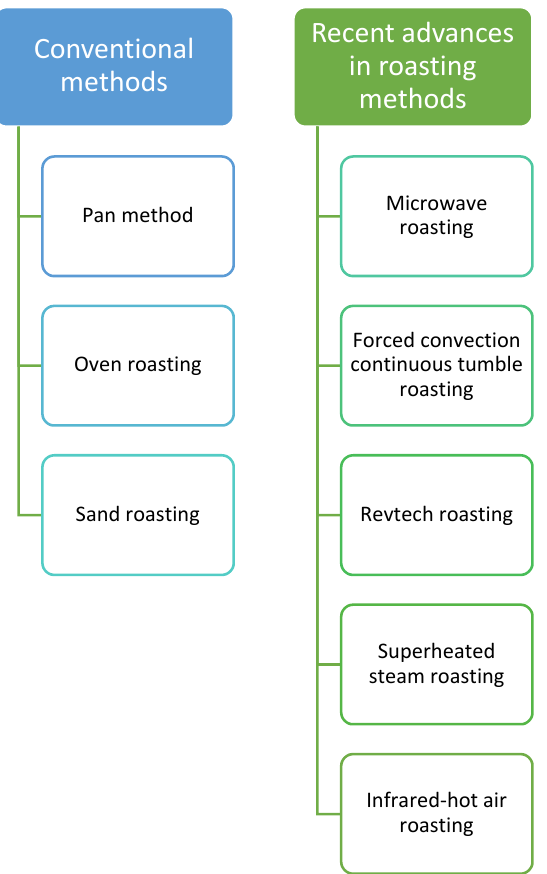
Figure 3. Conventional and emerging methods of roasting [109].